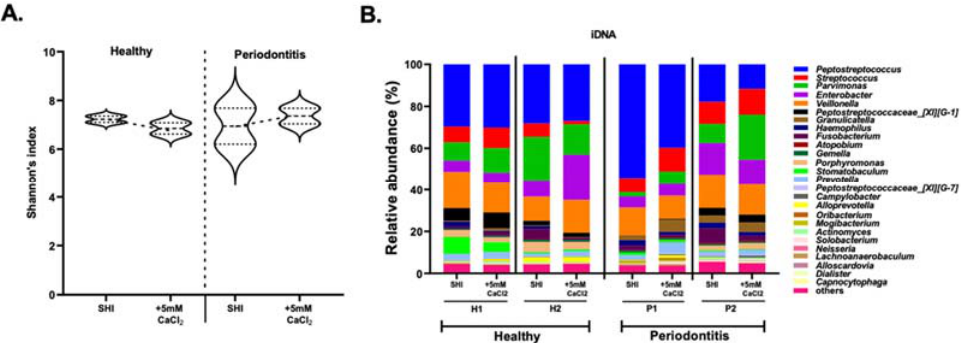
Figure 4. The effect of CaCl 2 supplementation on iDNA. ( A ) Alpha diversity analysis of iDNA representation of biofilms derived from the saliva of healthy (H) and periodontitis (P) patients. The biofilms were grown in SHI medium (SHI) and SHI medium + 5 mM CaCl 2 (+5 mM CaCl 2 ). Violin plots representing the alpha diversity of iDNA in the absence and presence of +5 mM CaCl 2 are shown. The median line represents the average while the dotted lines represent minimum to maximum value. Alpha diversity is measured by Shannon’s index, representing mean species richness. ( B ) Genus-level microbial composition of iDNA from healthy (H1, H2) and periodontitis (P1, P2) patients as revealed by 16S rRNA gene sequencing. Bar plots represent the relative abundance of genera present in the oral biofilm communities formed in SHI medium (SHI) and SHI medium + 5 mM CaCl 2 (+5 mM CaCl 2 ). Except for minor differences in the abundance of some genera, the iDNA of both healthy subjects and periodontitis patients showed similar community profiles in SHI medium and SHI medium + 5 mM CaCl 2 (Figure